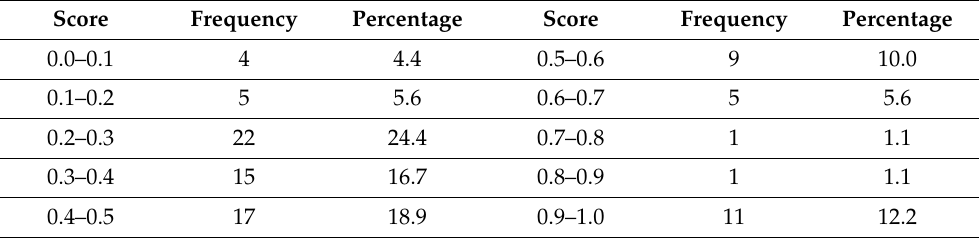
Table 4. Frequency table of BCC DEA results.